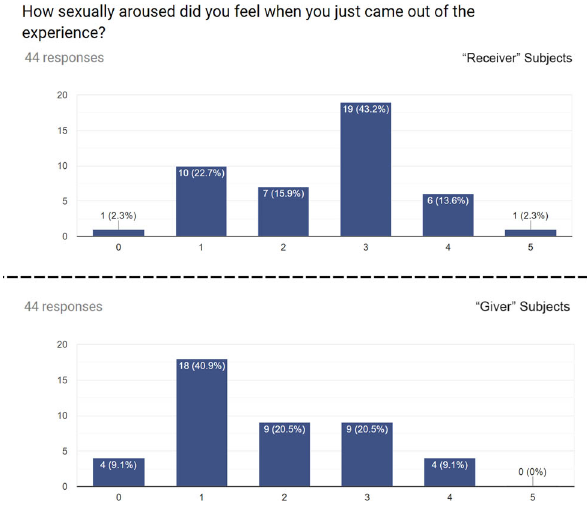
Figure 13: Charts showing rating of arousing elements, subjects extracted from the self - report forms. “ Solo ” ( above ) and “ Coupler ” ( below )